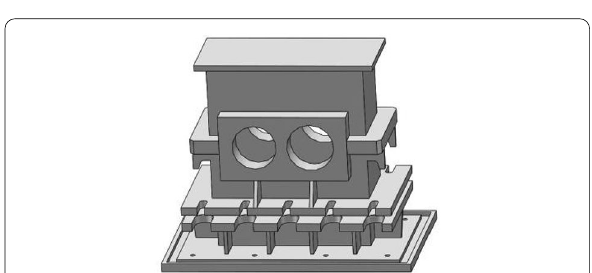
Figure 2 Solid model of gearbox